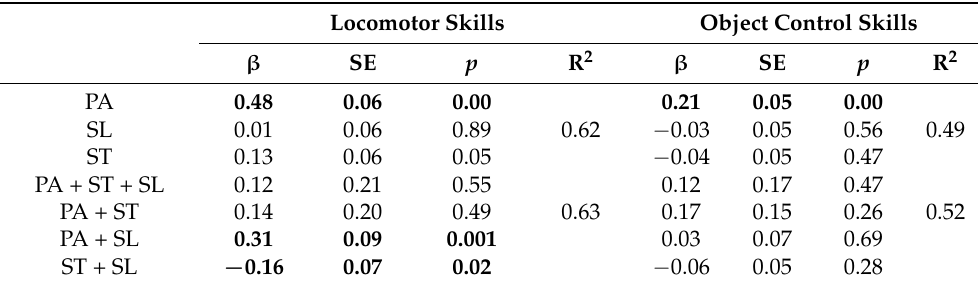
Table 4. Associations between meeting 24-Hour Movement Guidelines met and fundamental motor skills in